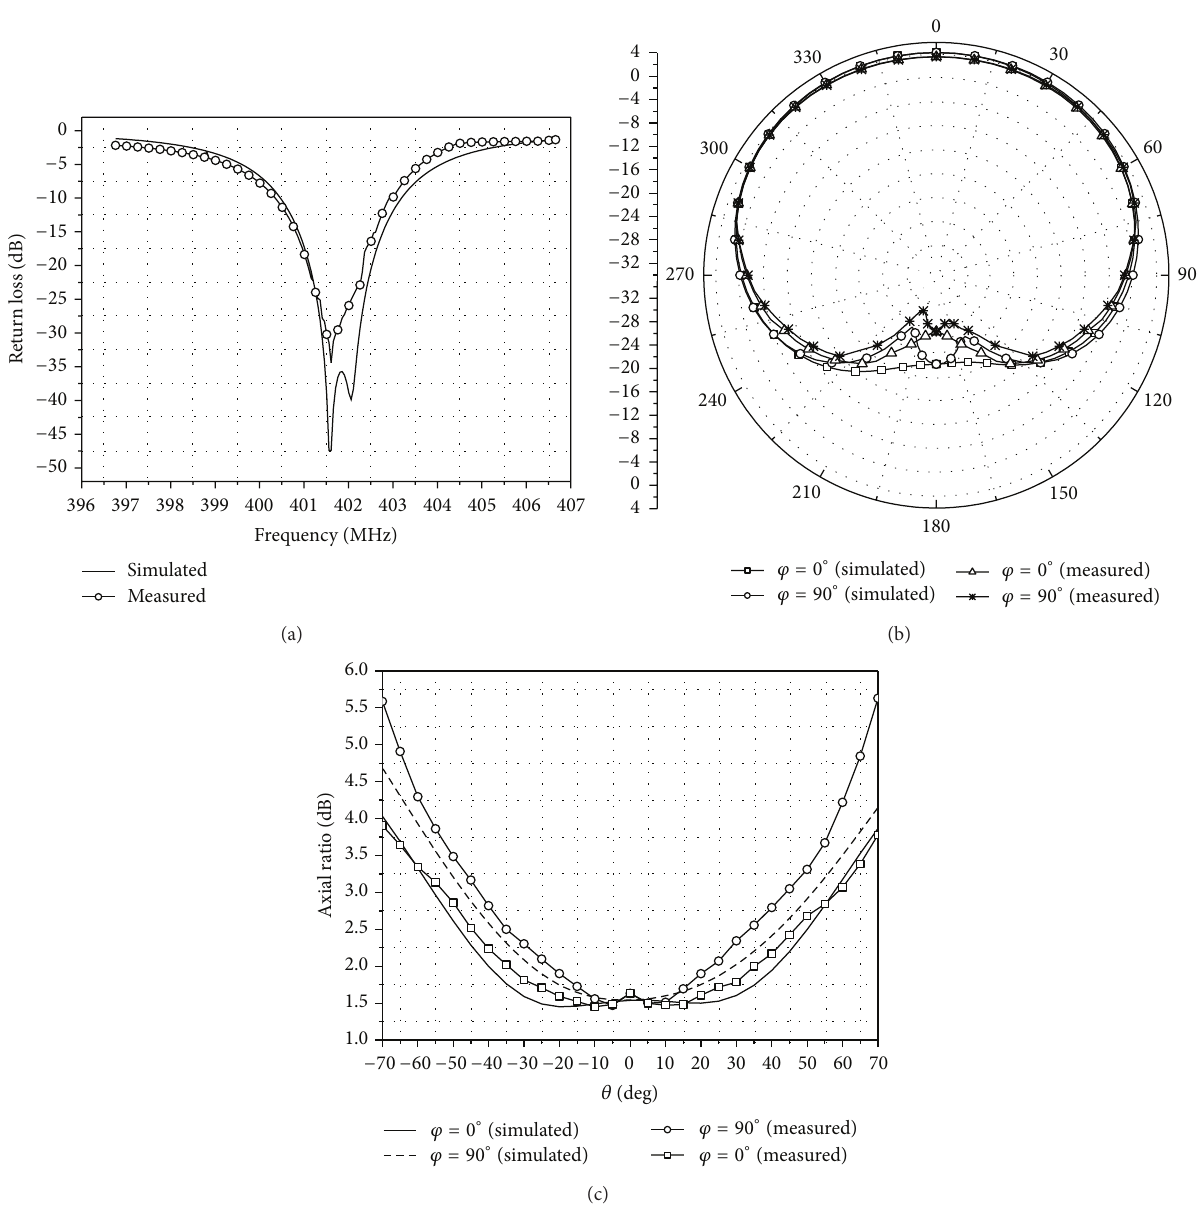
Figure 6: Antenna performance at f = 401.6MHz: (a) return loss, (b) RHCP radiation pattern at 𝜑 = 0 ∘ , 𝜑 = 90 ∘ , and (c) axial ratio pattern at 𝜑 = 0 ∘ and 𝜑 = 90 ∘